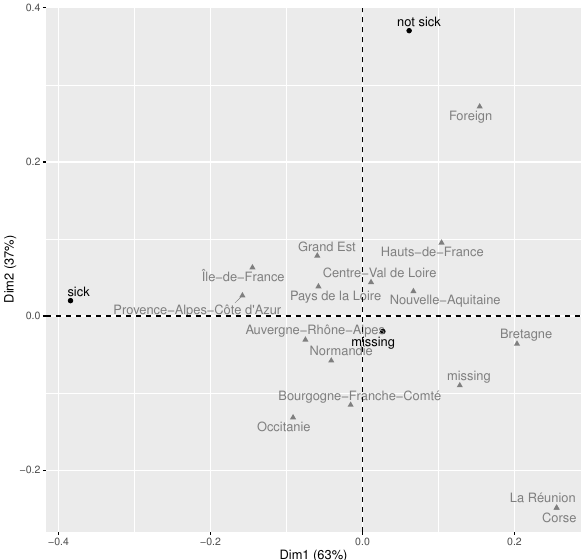
Figure 5. COVID by geographical region: correspondence analysis, employees ( n = 1746), the two first factorial dimensions are presented. A proportion of total explained variance is indicated for each